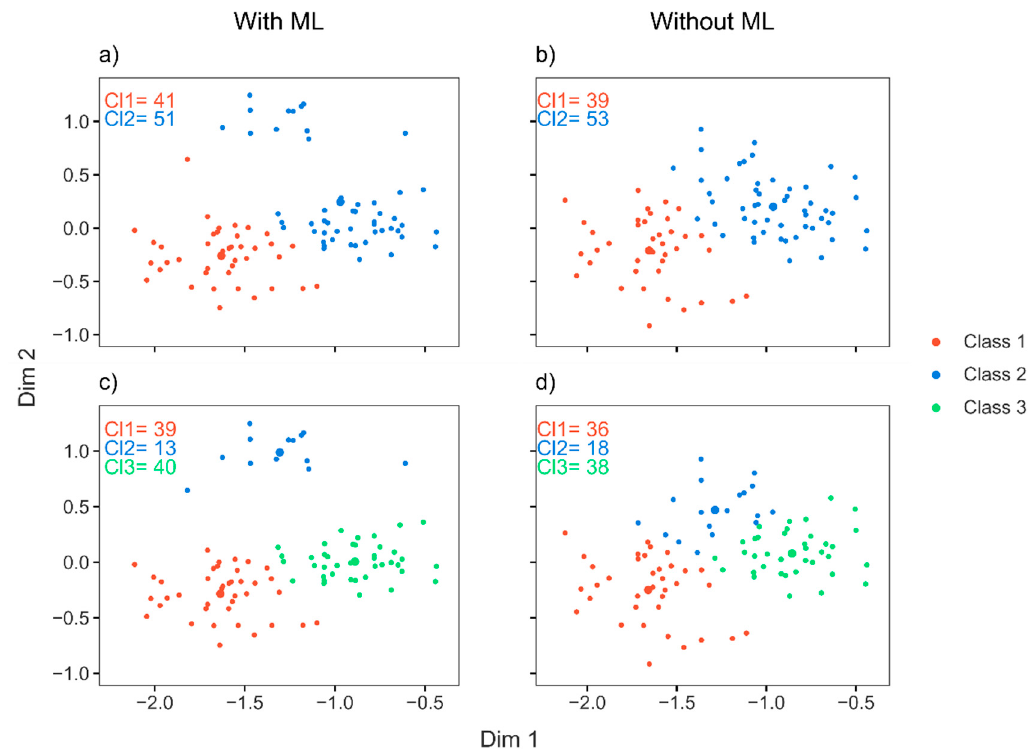
Figure 8. The classified rainfall events based on cluster analysis: ( a ) two classes (with Melting Layer—ML feature), ( b ) two classes (without ML feature), ( c ) three classes (with ML feature), ( d ) three classes (without ML feature). Cl1, Cl2, Cl3 are the number of events per each class.